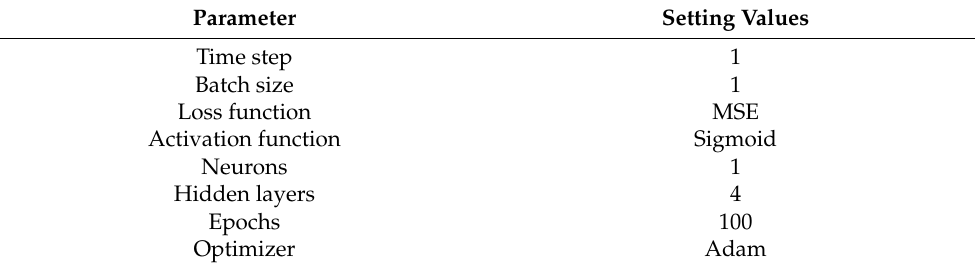
Table 1. LSTM parameter